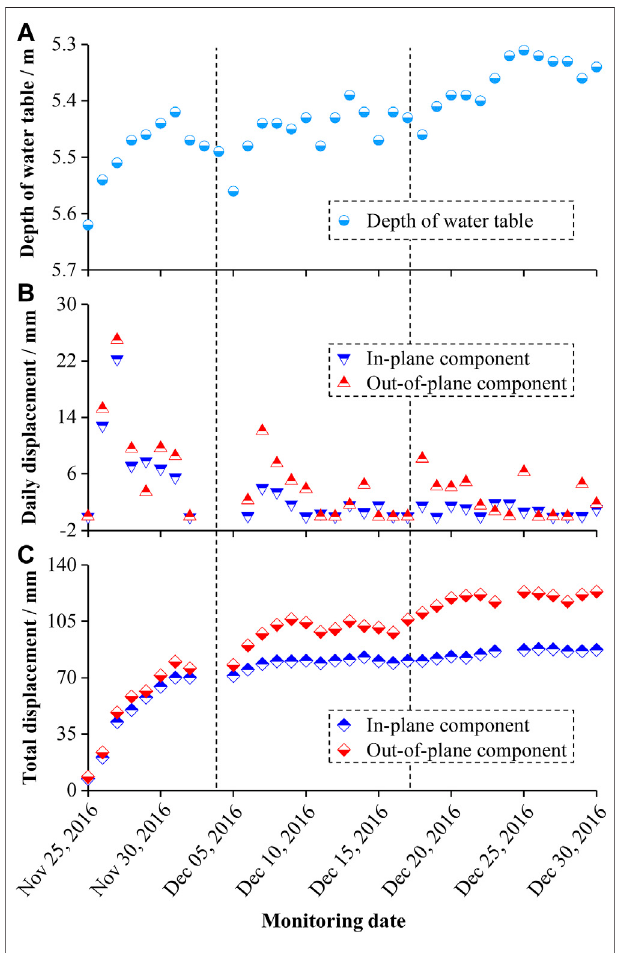
FIGURE 2 | Monitoring data of the slope: (A) depth of water table, (B) daily displacement, and (C) total displacement.